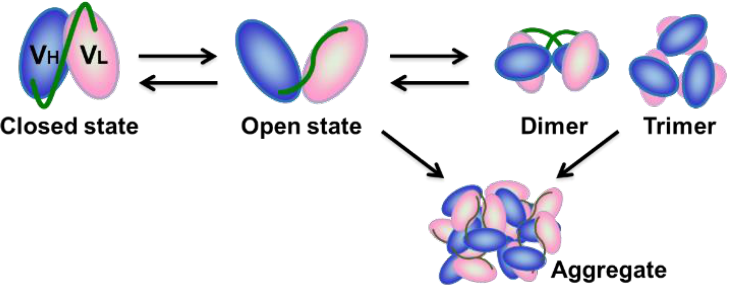
Figure 1. Schematic model of the open-closed dynamics and the aggregation process of single-chain Fv (scFv). ScFv protein in the open state triggers the formation of dimer, trimer, and larger aggregates mediated by inter-chain heavy chain (VH)-light chain (VL) interactions.